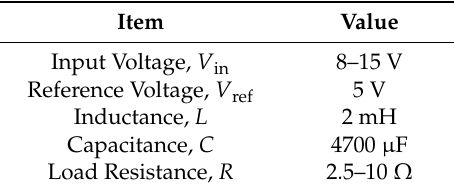
Table 1. Design index and circuit